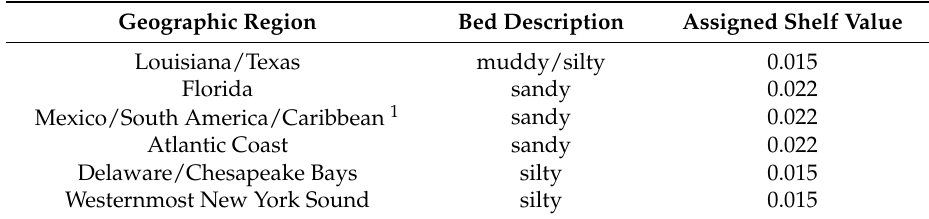
Table 3. Geographic regions used for Manning’s n assignment from usSEABEDS